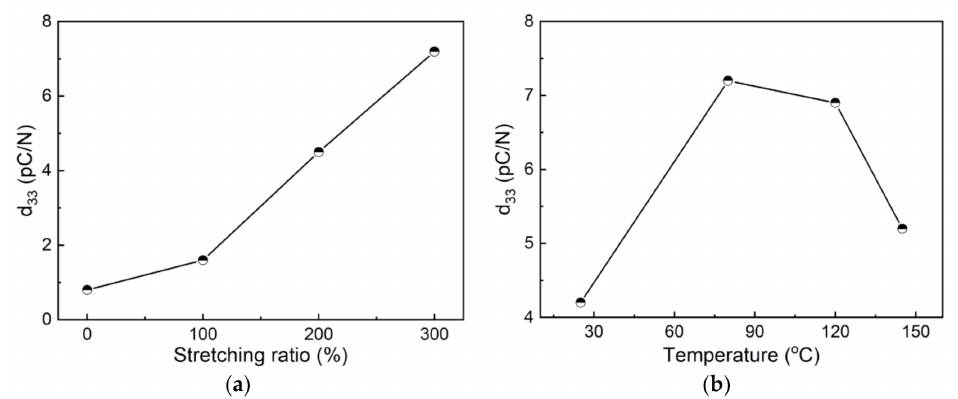
Figure 9. Piezoelectric coefficients (d 33 ) of the nylon-11 films as a function of the ( a ) stretching ratio and ( b ) stretching temperature.